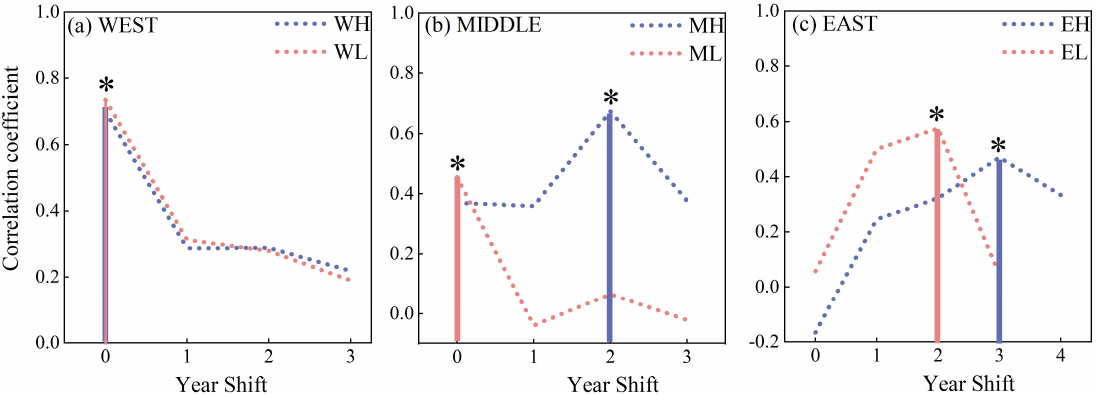
Figure 6. Correlations between TRW and EVI at two elevations of western ( a ), central ( b ) and eastern ( c ) regions of the Qilian Mountains from 2000 to 2020. * p < 0.05.